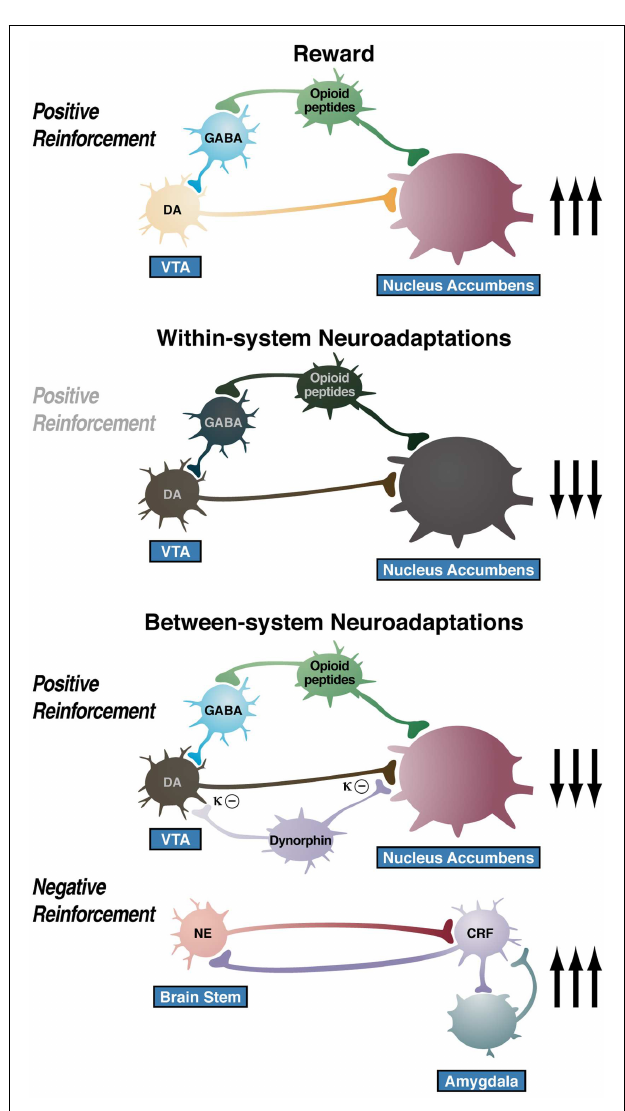
FIGURE 9 | Diagram of the hypothetical “within-system” and “between-system” changes that lead to the “darkness within .” (Top) Circuitry for drug reward with major contributions from mesolimbic dopamine and opioid peptides that converge on the nucleus accumbens. During the binge/intoxication stage of the addiction cycle, the reward circuitry is excessively engaged, Middle. Such excessive activation of the reward system triggers “within-system” neurobiological adaptations during the withdrawal/negative affect stage, including activation of cyclic adenosine monophosphate (cAMP) and cAMP response element-binding protein (CREB), downregulation of dopamine D 2 receptors, and decreased firing of ventral tegmental area (VTA) dopaminergic neurons, Bottom. As dependence progresses and the withdrawal/negative affect stage is repeated, two major “between-system” neuroadaptations occur. One is activation of dynorphin feedback that further decreases dopaminergic activity.The other is recruitment of extrahypothalamic norepinephrine (NE)-corticotropin-releasing factor (CRF) systems in the extended amygdala. Facilitation of the brain stress system in the prefrontal cortex is hypothesized to exacerbate the between-system neuroadaptations while contributing to the persistence of the dark side into the preoccupation/anticipation stage of the addiction cycle [taken with permission from Ref.